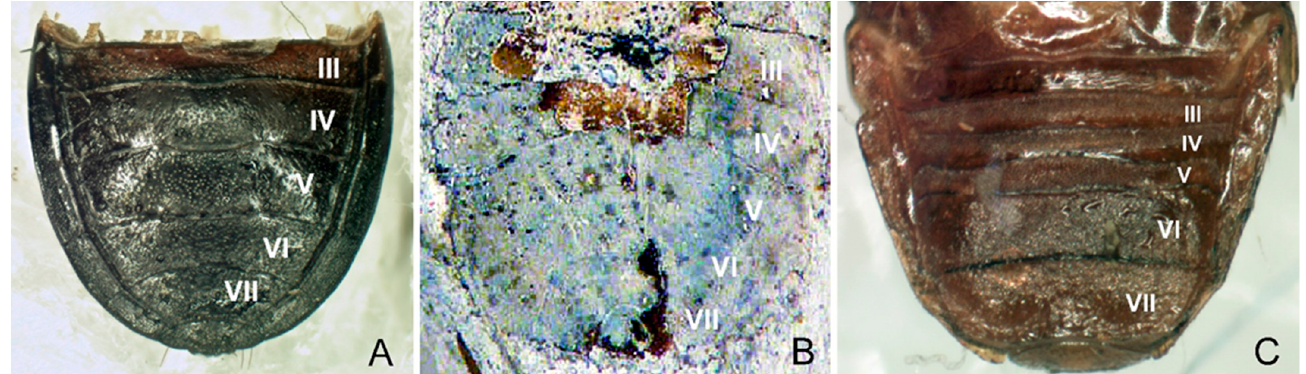
Figure 4. Abdominal segments III–VII, dorsal view. Cydnus aterrimus Forster, 1771 (Cydninae, Cydnini) ( A ), Eocenocydnus lisi ( B ), Amnestus brunneus Signoret, 1883 (Amnestinae) ( C ). ( A , C ) Original by J. A. Lis. ( B ) Courtesy of the Cambridge University Press, modified.